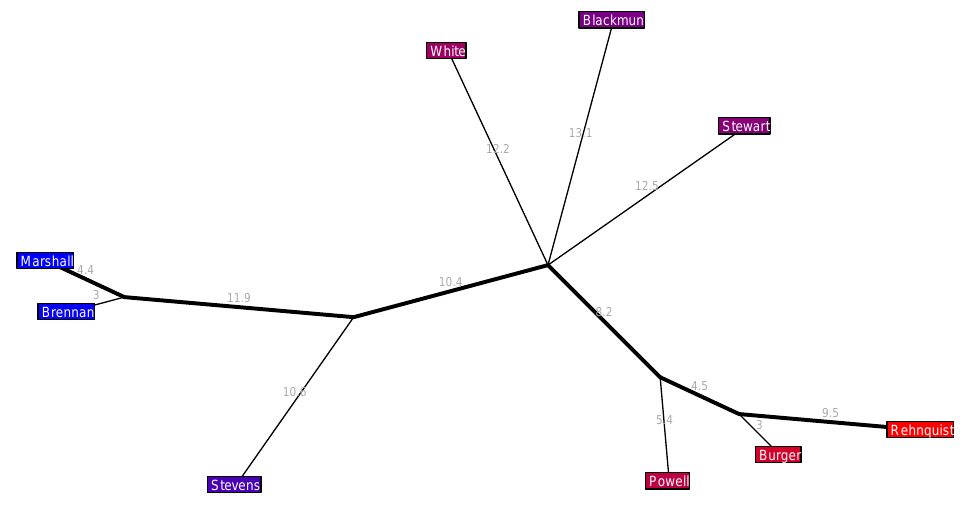
Figure 8. Judicial tree for the 1975–1981 Burger 6 Court.